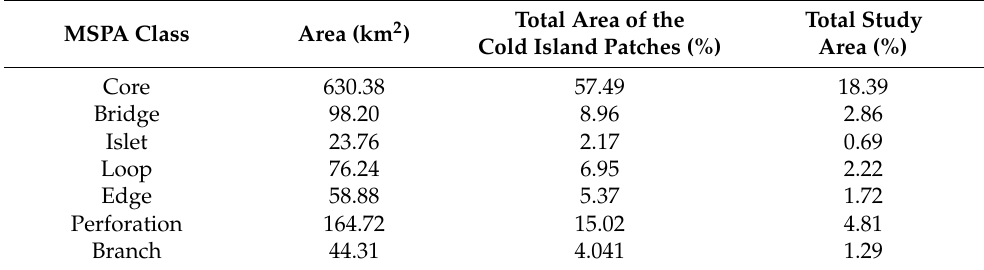
Table 7. MSPA Statistics